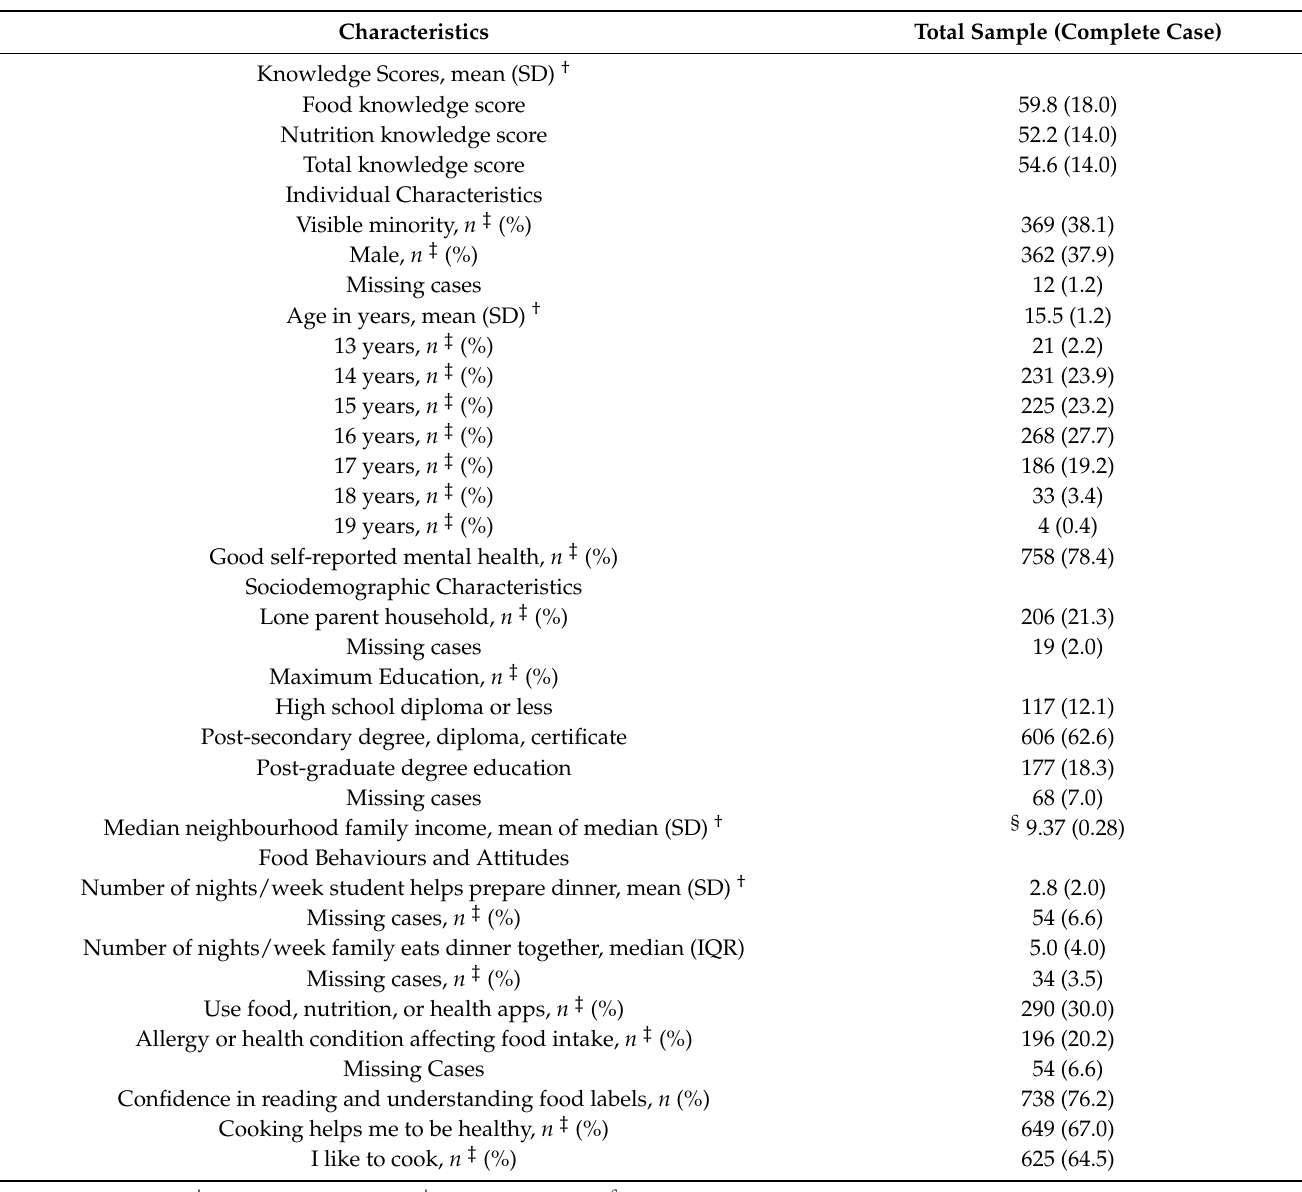
Table 3. Characteristics of the Sample (N =